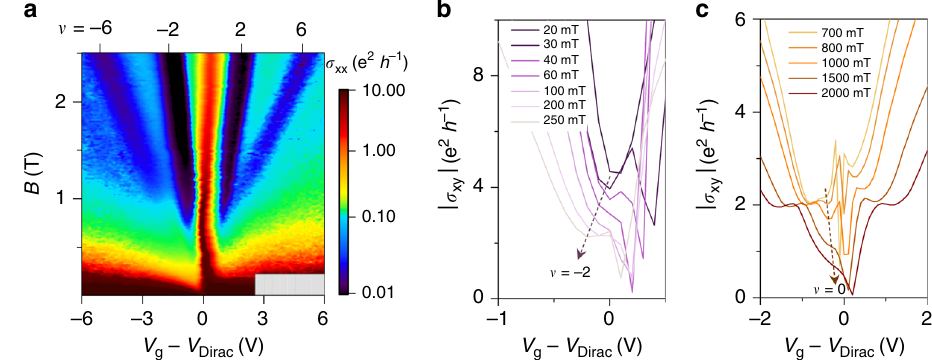
Fig. 5 Magneto-transport measurements of graphene. a The fan diagram of the longitudinal conductivity ( σ xx ) shows well-resolved quantum Hall states at the base temperature of 9 K. The measurements were made on the BGB-1 device of Fig. 4. b The transition of Hall conductivity ( σ xy ) to ν = − 2 commences at ≈ 40 mT. c The lifting of the zero-energy Landau level degeneracy begins at below 1 T. These observations indicate the high quality of the two- dimensional electronic system in our